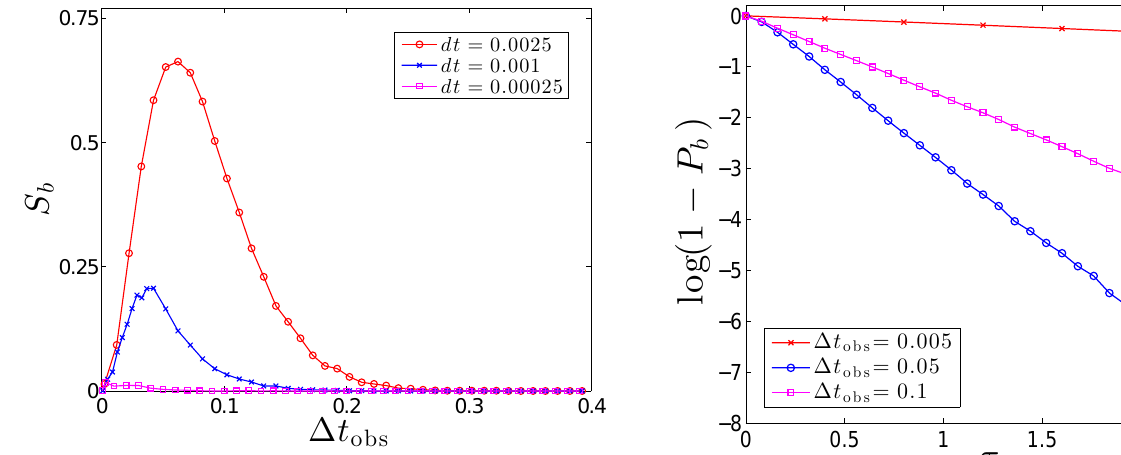
Fig. 2. Percentage S b of blow-ups as a function of the observation interval 1t obs for several values of the integration time step d t for fixed number of analyses cycles n a = 4000. We used R o = 0 . 01 and k = 6 ensemble members.